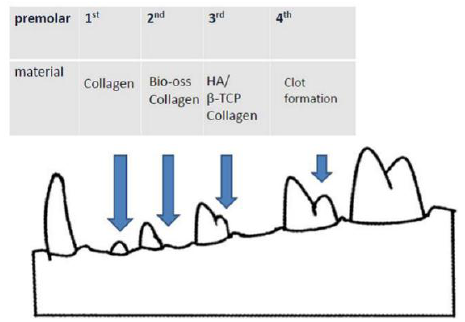
Figure 11. Surgical stent for the beagle’s mandible.